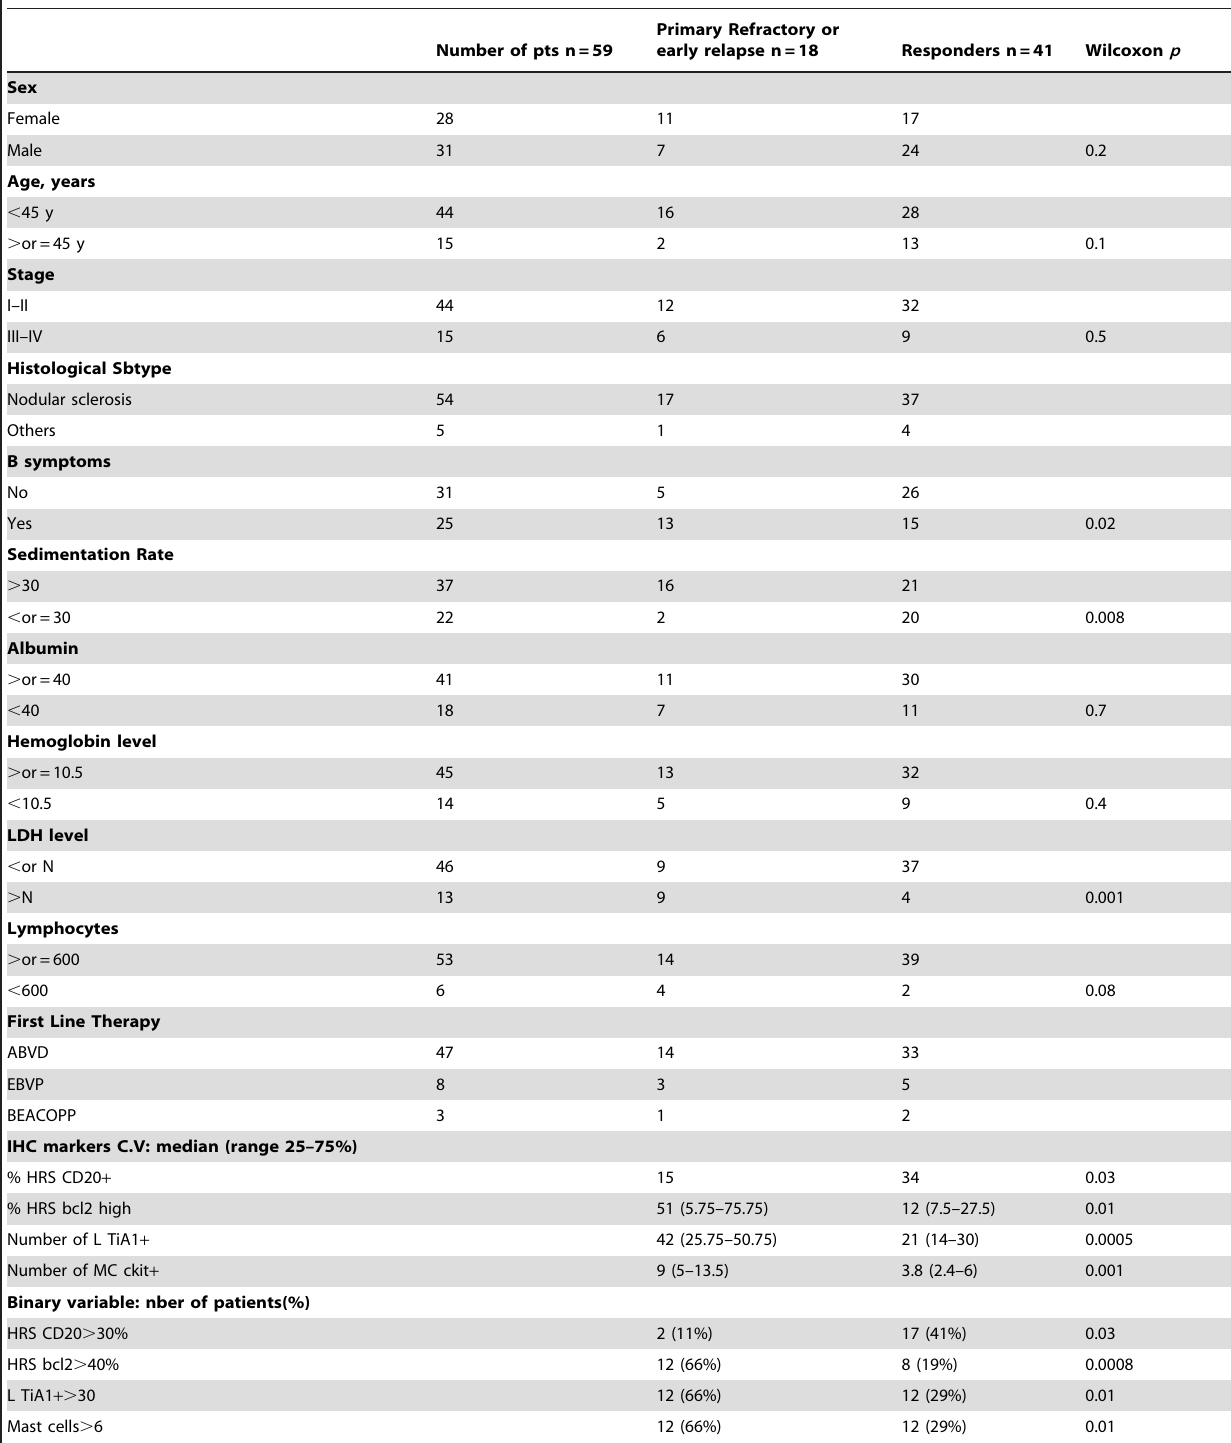
Table 1. Characteristics of patients & IHC markers (univariate